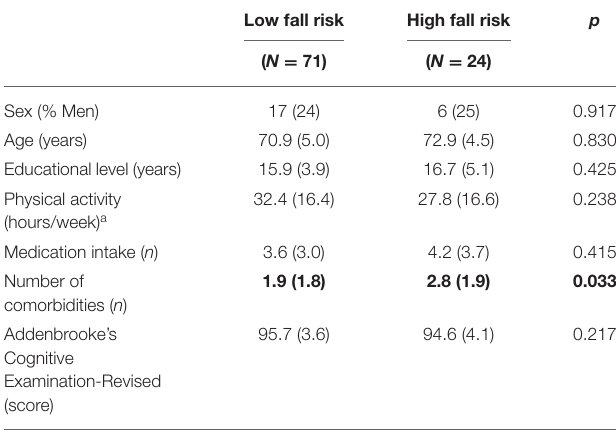
TABLE 2 | Demographic and clinical measures. Data are mean (SD) unless stated